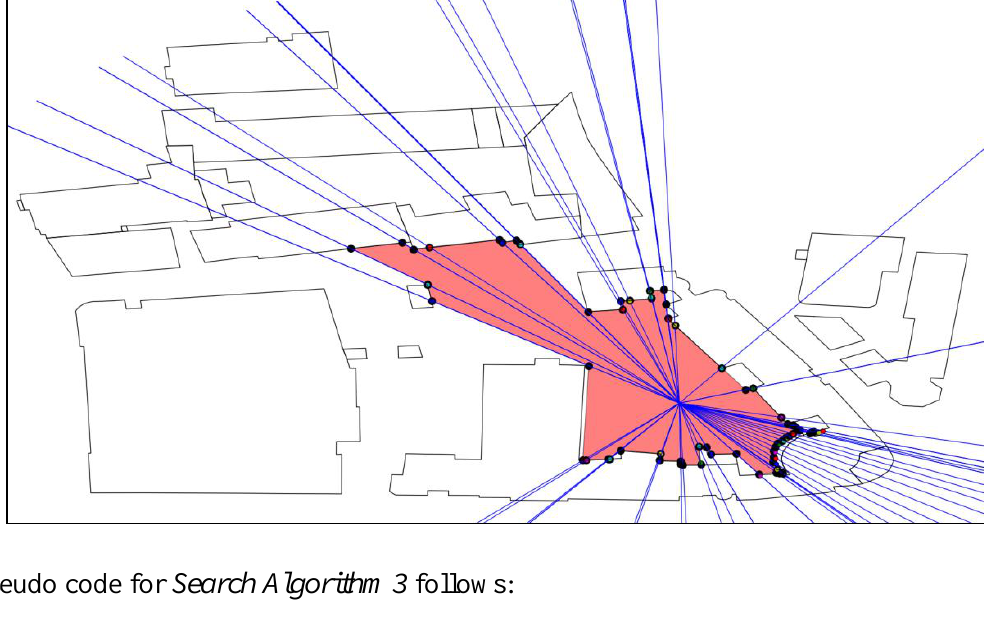
Algorithm 3: 2D Isovist Based Ray Sweeping